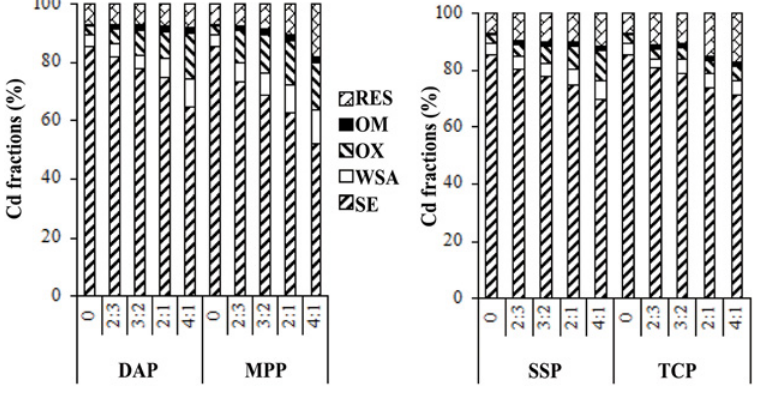
Fig 4. Effect of phosphate addition on fractions of Cd after 28 d